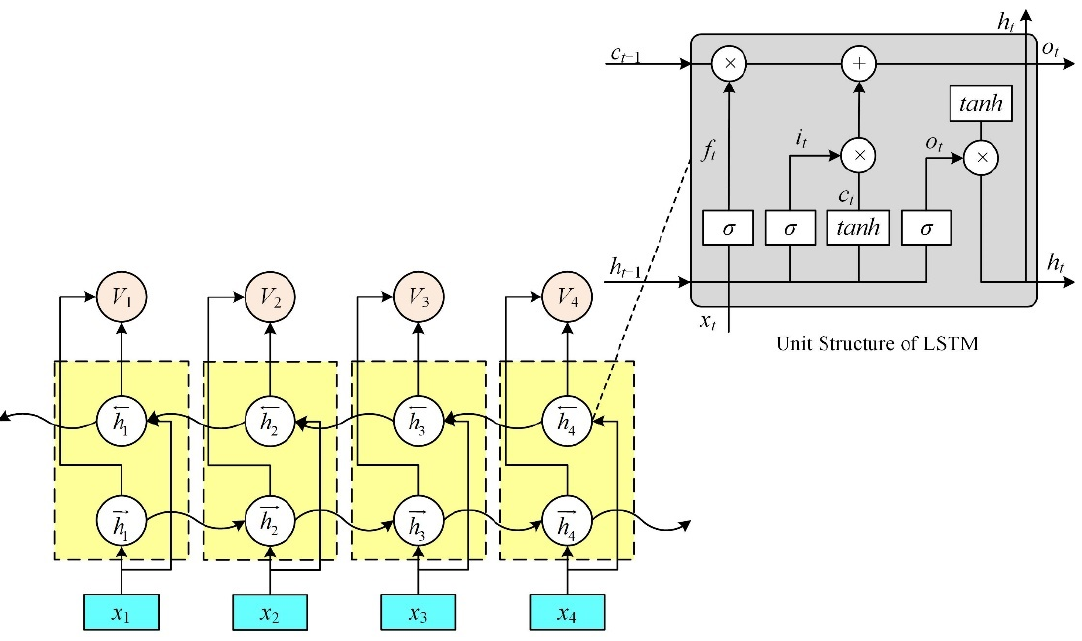
Figure 4. The structure of BiLSTM.